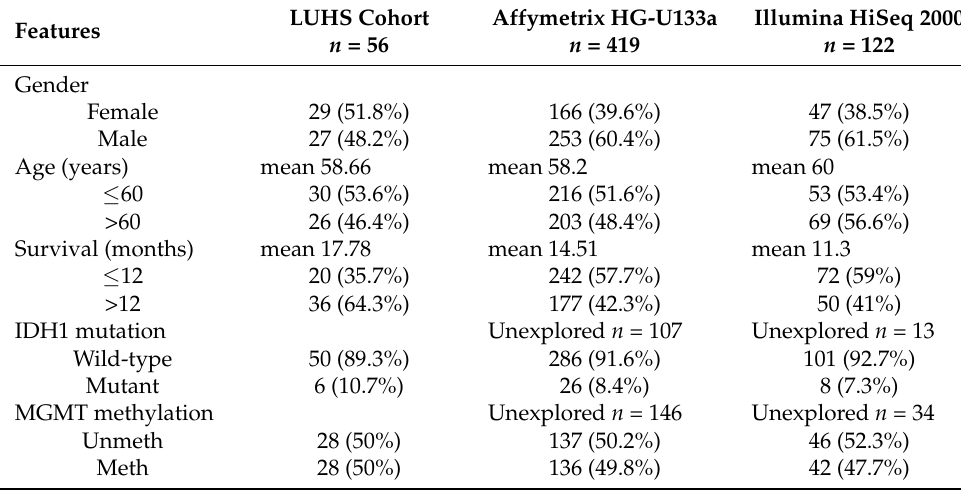
Table 3. Summary of patient molecular and demographical characteristics.